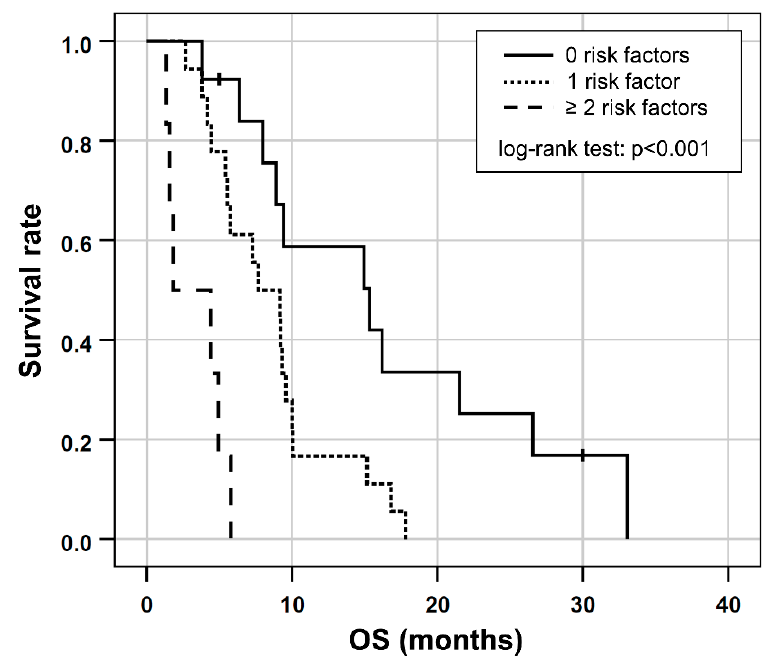
Figure 3. Kaplan-Meier plots for OS in patients separated by the number of risk factors according to the prognostic score based on ECOG > 1 and/or the presence of elevated GGT ≥ 750 [U/L] or low albumin ≤ 41.1 [g/L] at baseline.